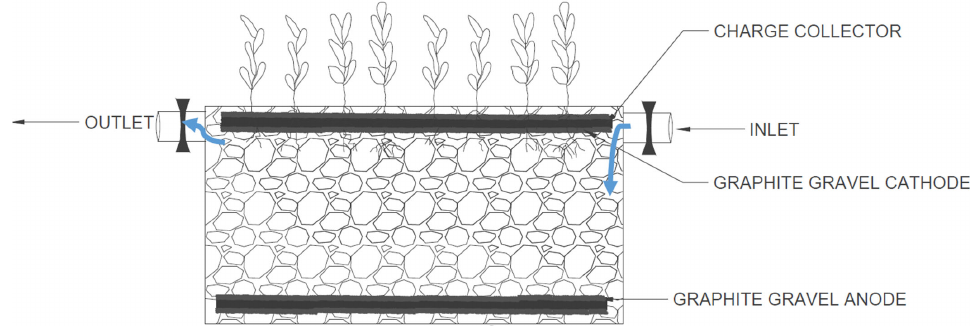
Figure 3. Representation of the closed-circuit horizontal subsurface constructed wetland-MFC ( adapted from Srivastava et al. (2020 ) [63]).